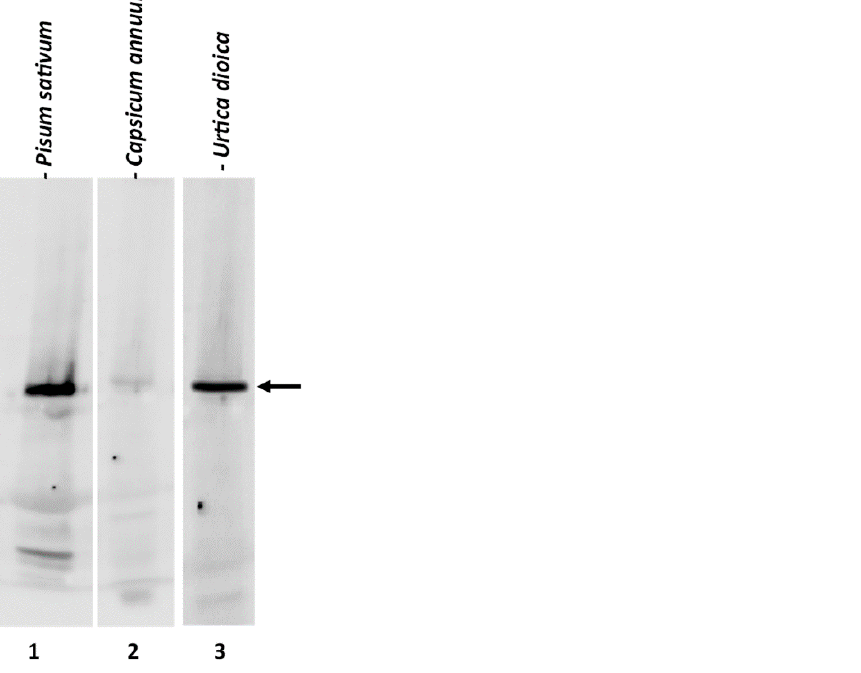
Figure 1. Western blot analysis of the specificity of the commercial antibody against sus-1 of Arabidopsis thaliana . Lane 1, extract from Pisum sativum leaves; lane 2, protein extract from Capsicum annuum leaves; lane 3, protein extract from Urtica dioica leaves. The three lanes contained about 30 µ g of protein. The anti-sus-1 antibody highlights a band with a molecular weight slightly higher than 75 kD in all three samples, although less intensely in the Capsicum annuum protein extract. Numbers on the left indicate the molecular weights in kD. The arrow indicates the position of the cross-reactive band.